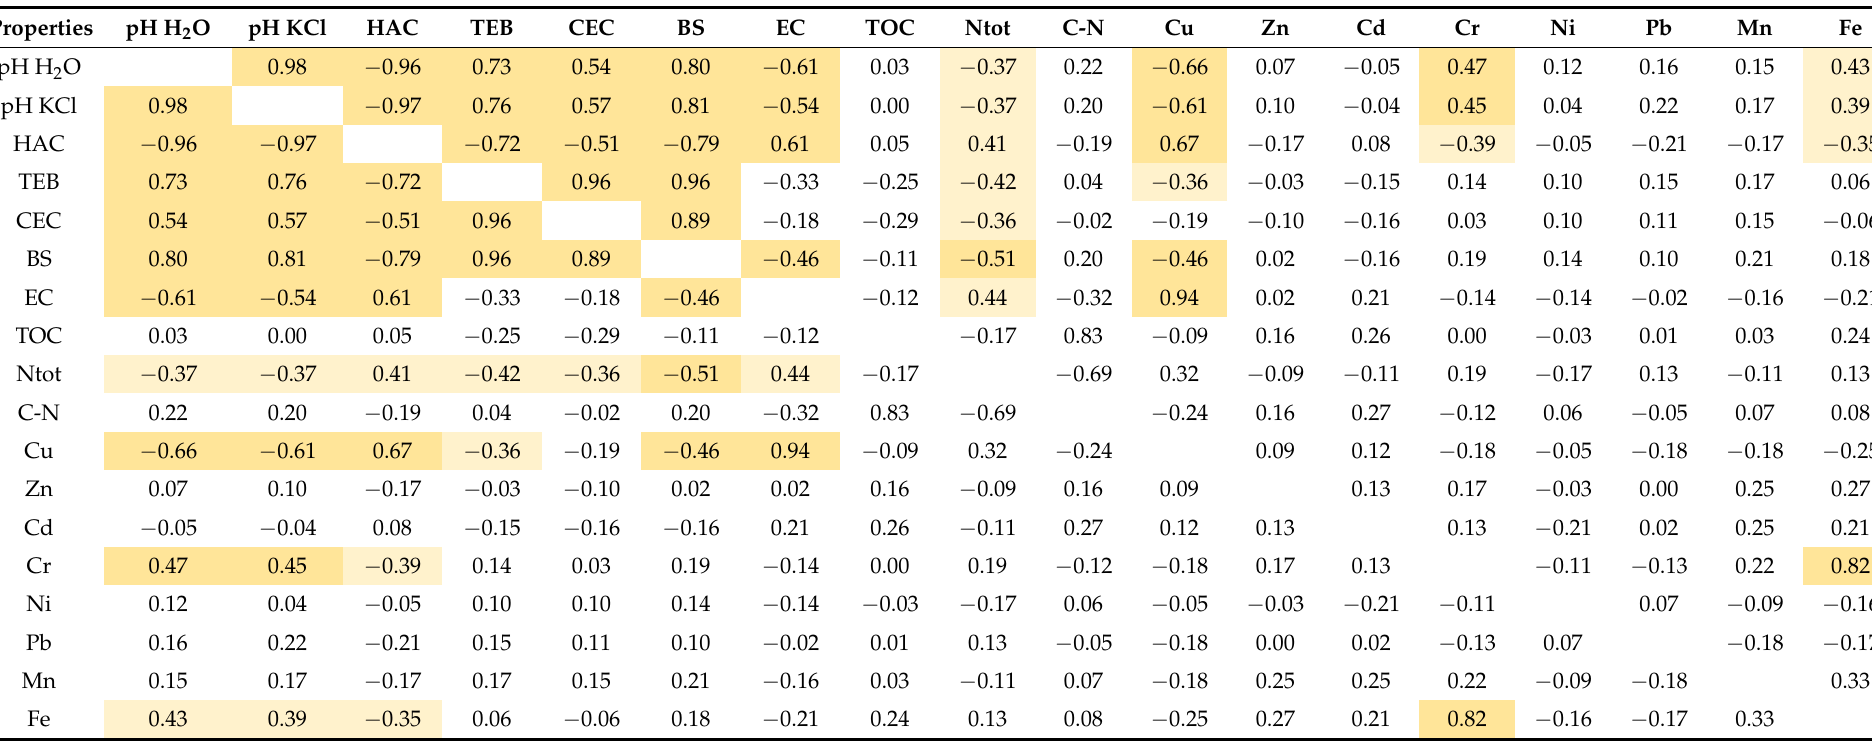
R —correlation coefficient significant at p ≤ 0.01—